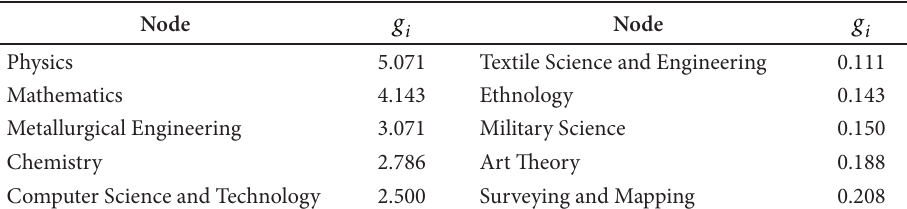
Table 4. Ratio of knowledge inflow and outflow of some nodes